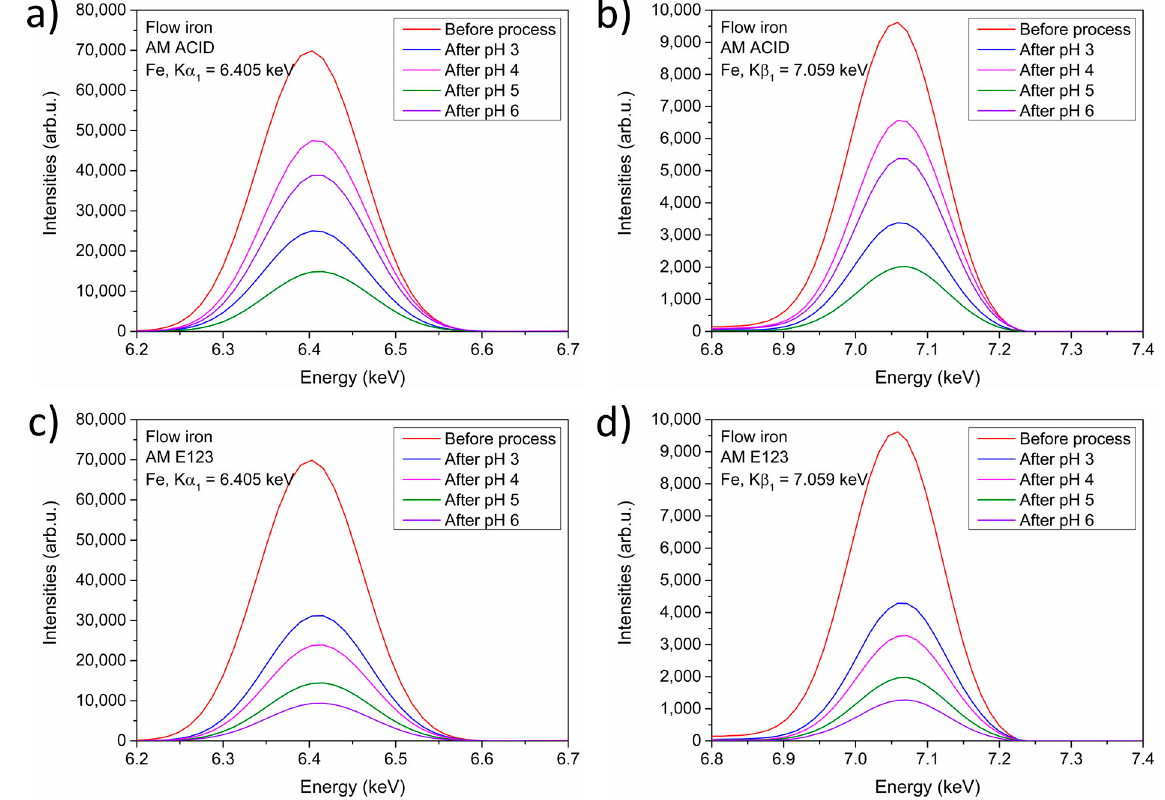
Figure 6. XRF analysis of the presence of iron in K α 1 = 6.405 keV after the process with ( a ) AM ACID and ( c ) AM E123. XRF analysis of the presence of iron in K β 1 = 7.068 keV after the process with ( b ) AM ACID and ( d ) AM E123.